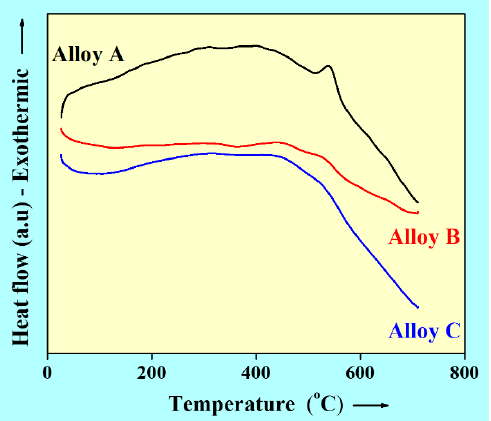
Figure 4. Differential scanning calorimetric results obtained from the 20 h mechanically alloyed powders from Alloy A, Alloy B, and Alloy C.